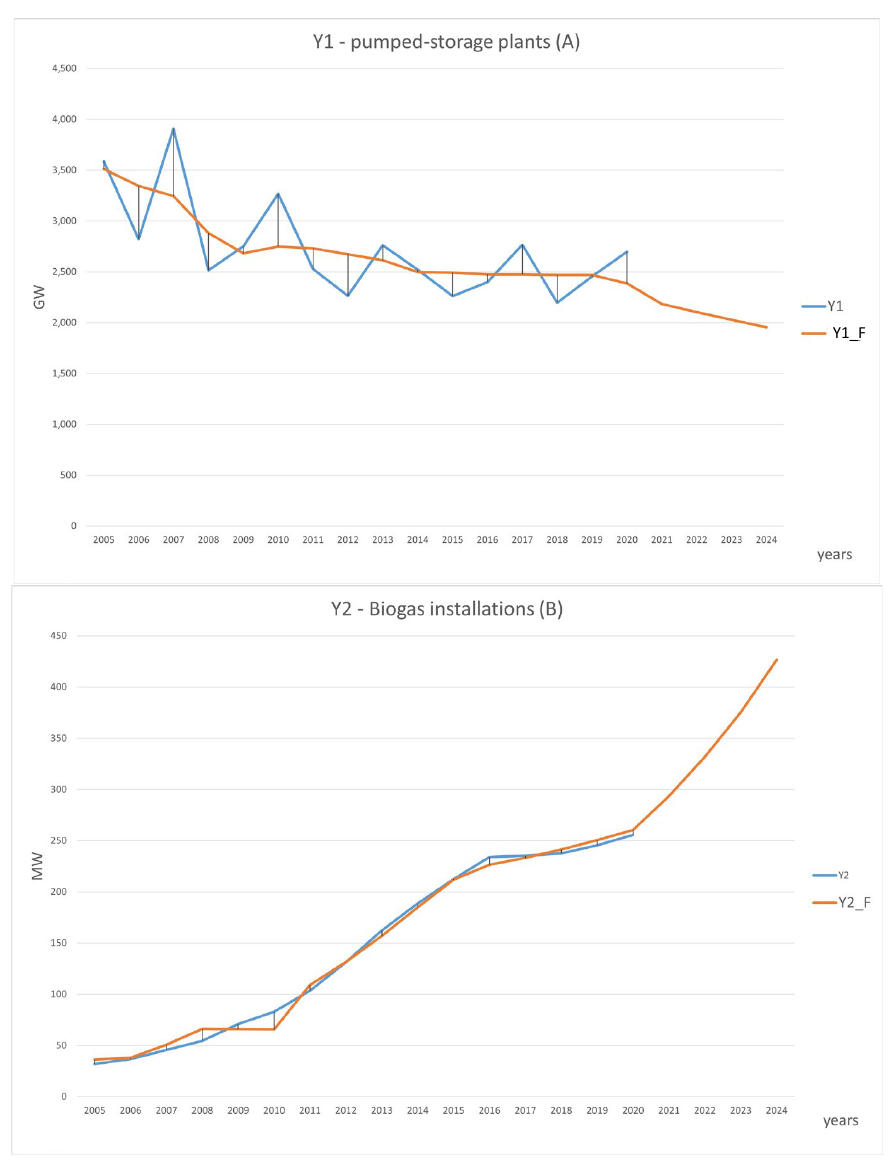
Table 9. Y-variable forecast values obtained on the basis of selected models.